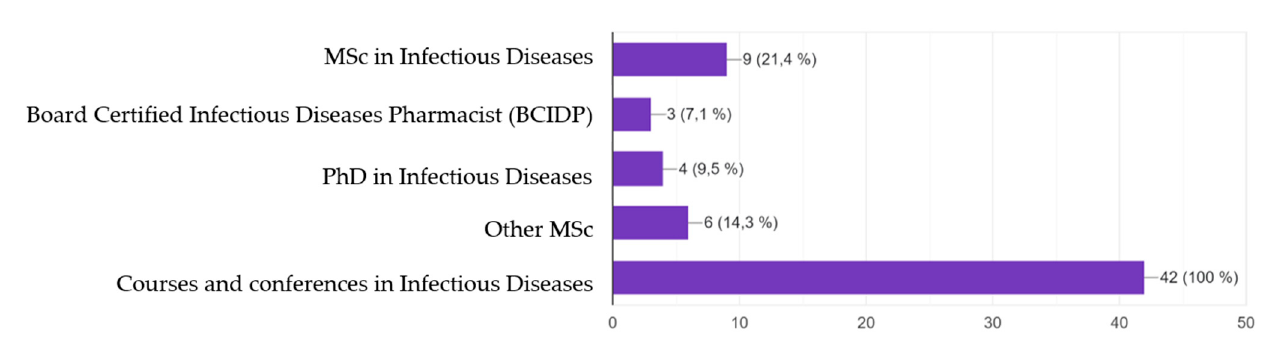
Figure 1. Clinical pharmacists’ training in infectious diseases. Participants may have more than one clinical training.